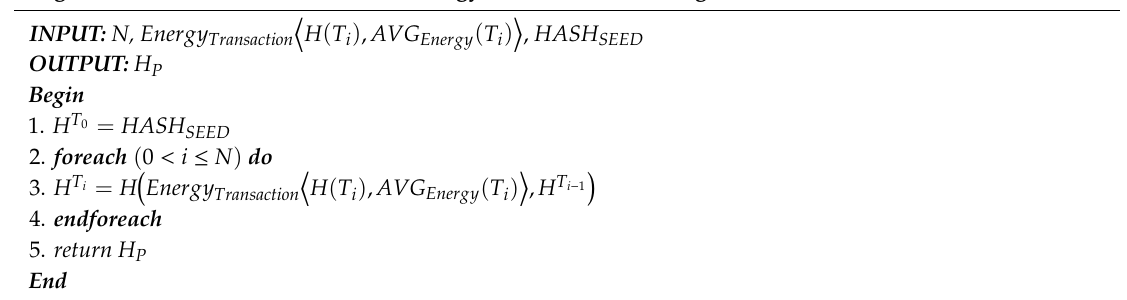
Algorithm 2: On-Chain Linked Back Energy Transactions